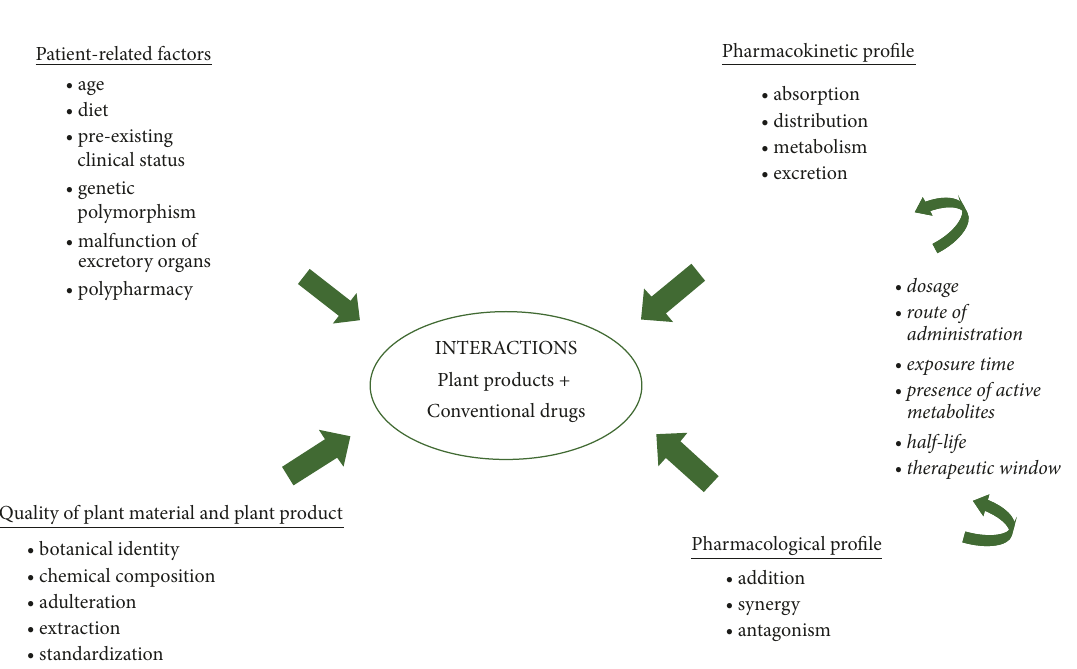
Figure 1: The important risk factors that influence the occurrence of interactions between plant products and conventional drugs.